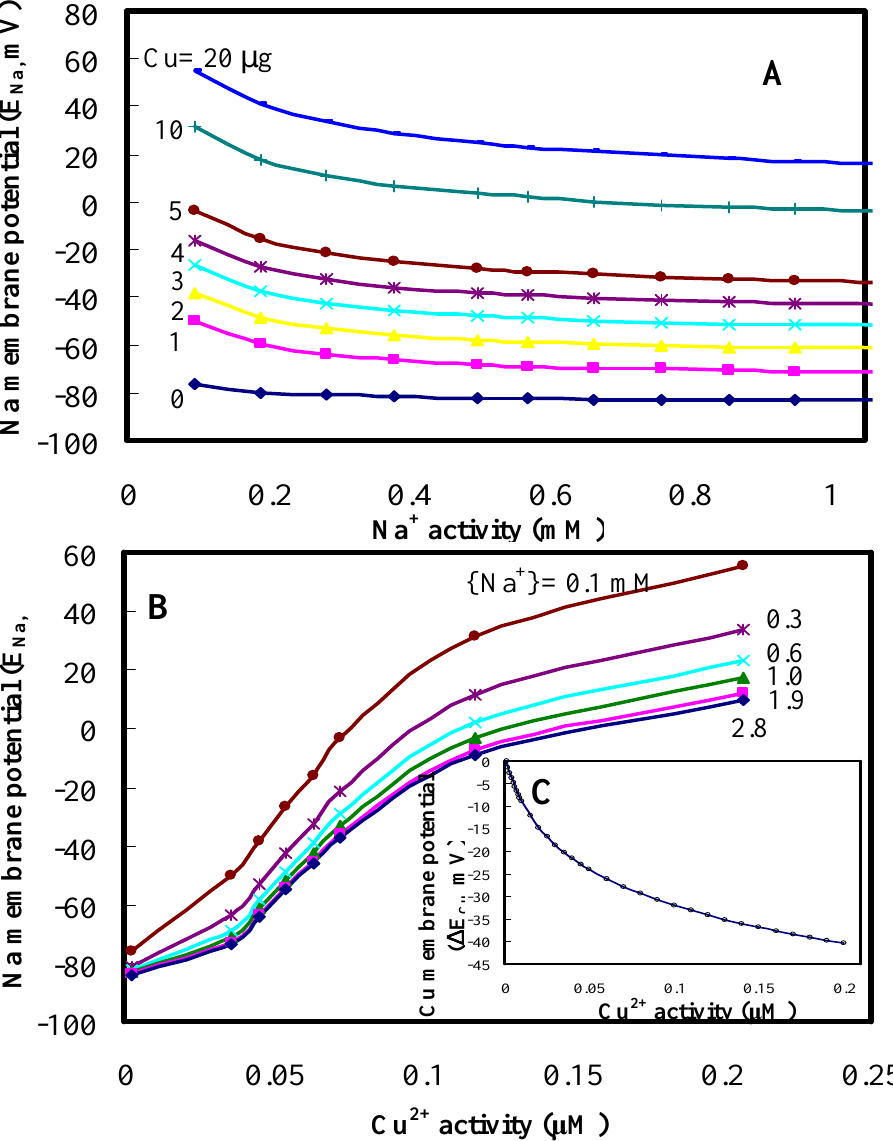
Figure 2. Predictions of clam gill membrane potentials. (A) Na + activity-dependent Na membrane potentials in response to Cu ranging from 0 to 20 m g L -1 . (B) Cu 2+ activity-dependent Na membrane potentials at Na + activity ranging from 0.1 to 2.8 mM. (C) Cu membrane potential changes range from 0 to - 40.4 mV varied with Cu + activity ranging from 0 - 0.2 m